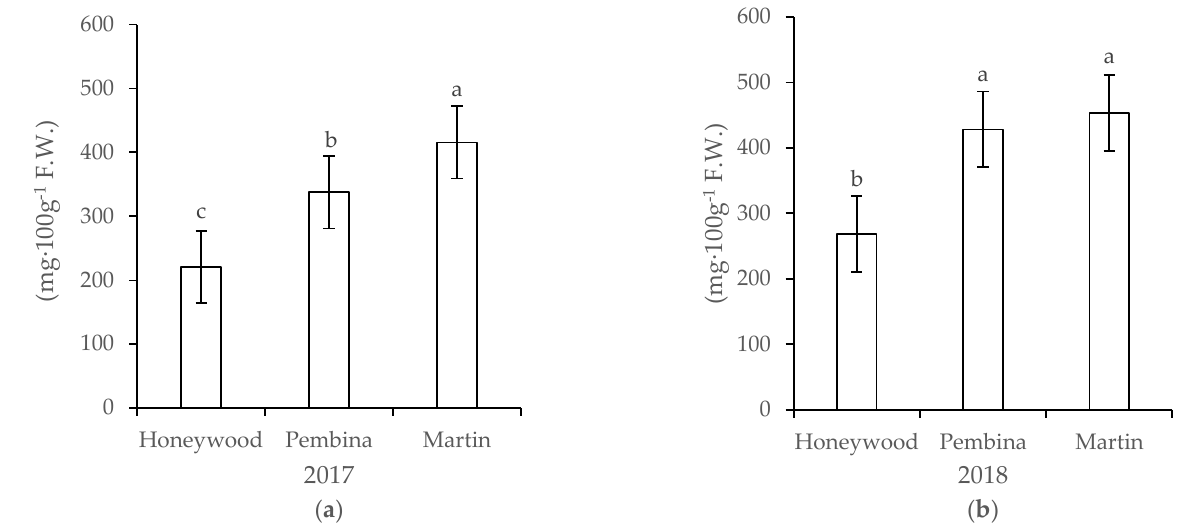
Figure 8. Total flavonoid content in the fruits of the studied cultivars in ( a ) 2017 and ( b ) 2018. Values with different letters are significantly different within a year.